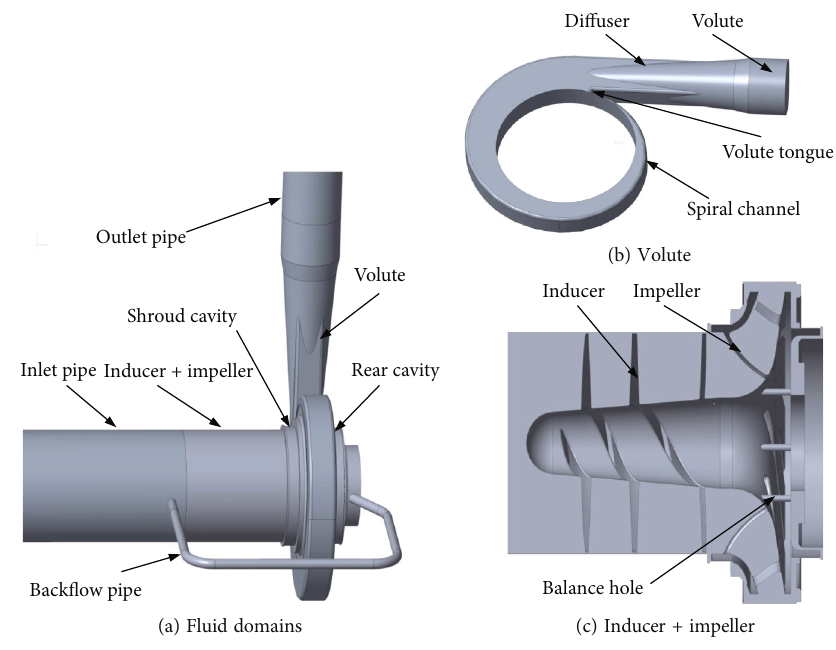
Figure 4: Fluid domains and 3D model of the